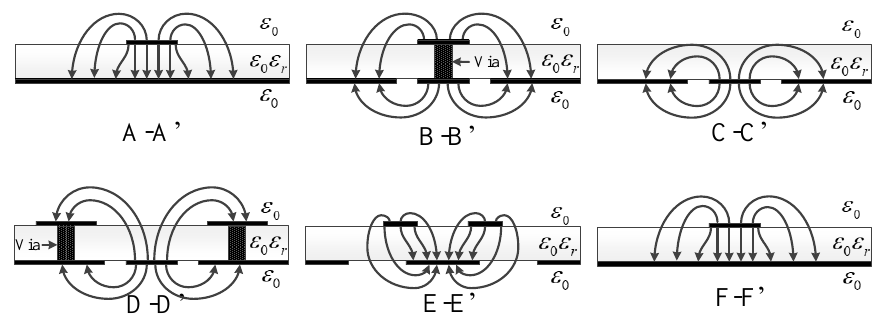
Figure 3. Cross-sectional views of simplified electric field distributions.